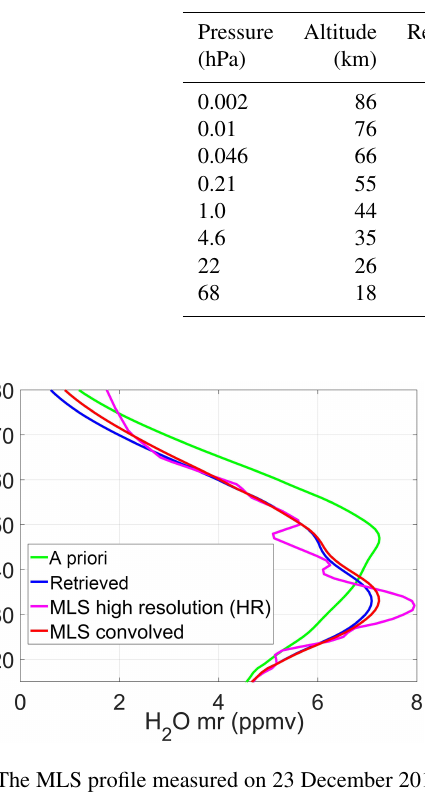
Figure 12. The MLS profile measured on 23 December 2016, with its high original vertical resolution (HR, magenta line) compared with the a priori profile (green line), the MLS convolved profile ob- tained from Eq. (31) (red line), and the VESPA-22 retrieved profile (blue